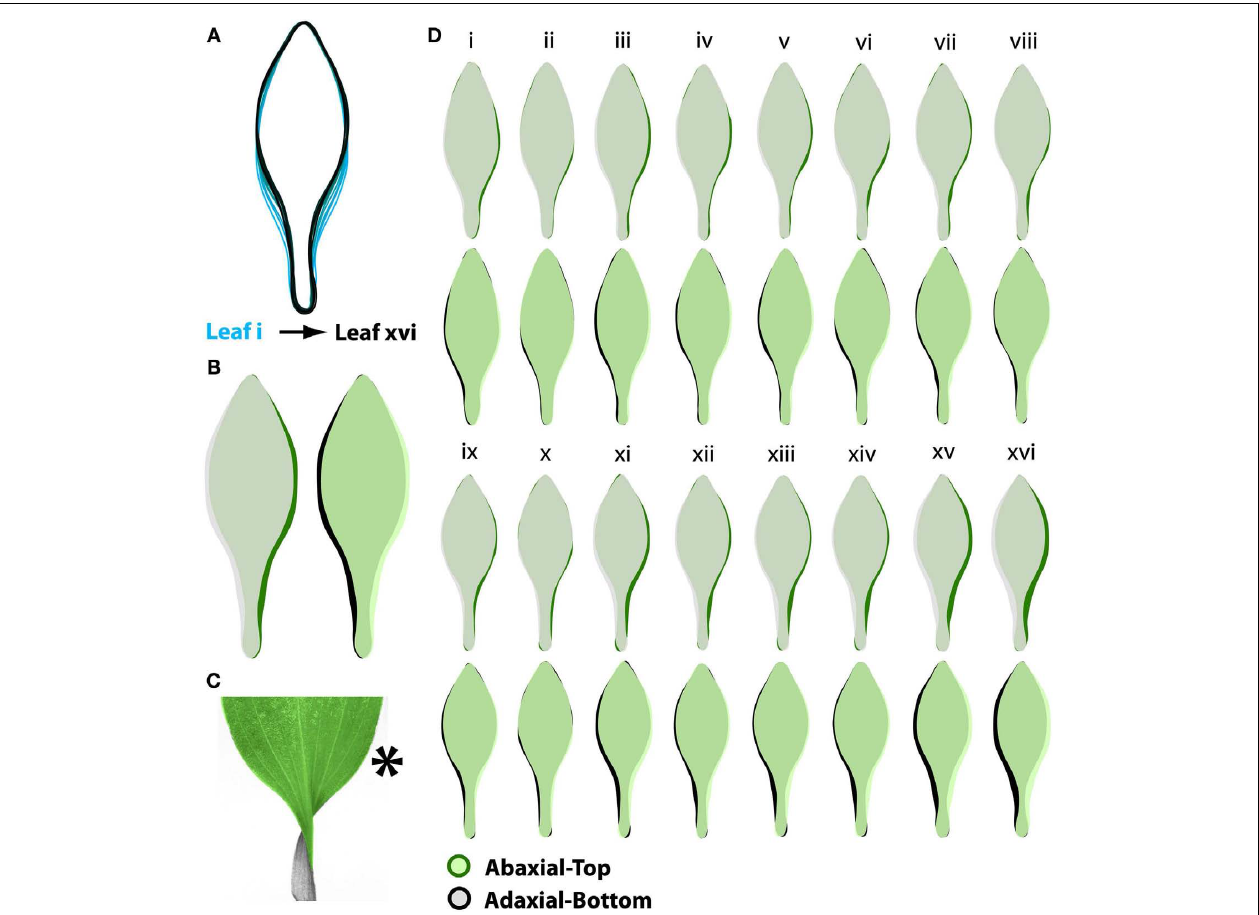
On the left, adaxial-bottom is placed over abaxial-top, and on the right vice versa . Note that there is more laminar outgrowth on the right side of the abaxial-top images, suggesting intrinsic asymmetry. (C) To place in perspective the asymmetries shown in (B) , a resupinate leaf is shown false-colored green and gray on its abaxial-top and adaxial-bottom sides, respectively.The asterisk denotes the side of the leaf on which excess blade outgrowth is observed. (D) Outlines of abaxial-top and adaxial-bottom images at each position in the leaf series. Note the consistency (albeit less severe) of the asymmetries at each node compared to (B) , in which leaves at all nodes are averaged together.